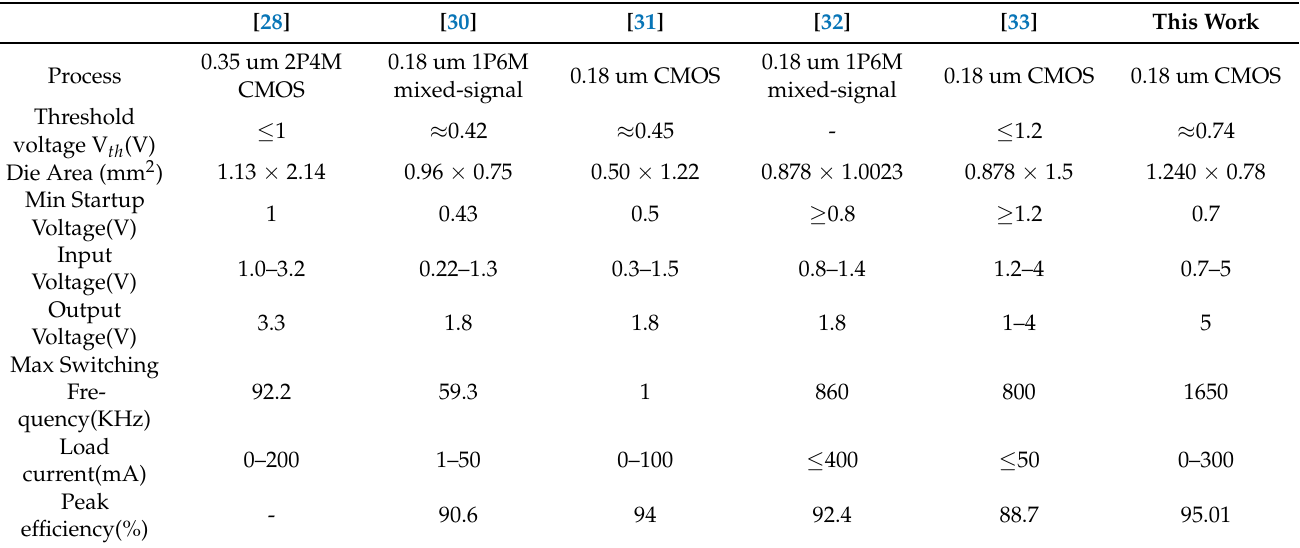
Table 1. Performance comparison with prior